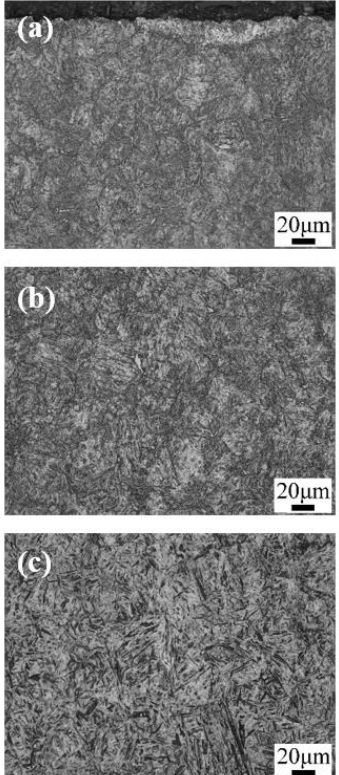
Figure 3. Optical micrographs of the microstructure after carburizing and quenching: ( a ) the surface; ( b ) the subsurface; and ( c ) the core. Materials 2020 , 13 , x FOR PEER REVIEW